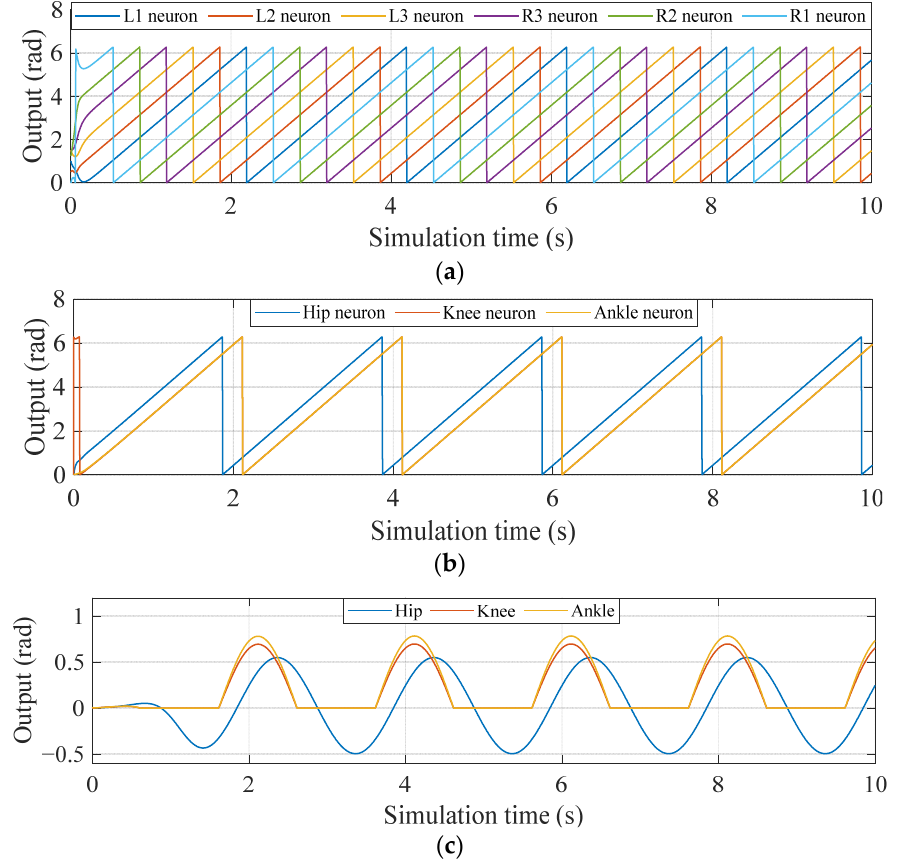
Figure 3. The signals of the proposed double ‐ layered CPG network. ( a ) The output of neurons in the rhythm layer; ( b ) the output of neurons in the pattern layer; ( c ) the trajectories of the three joints in a leg.